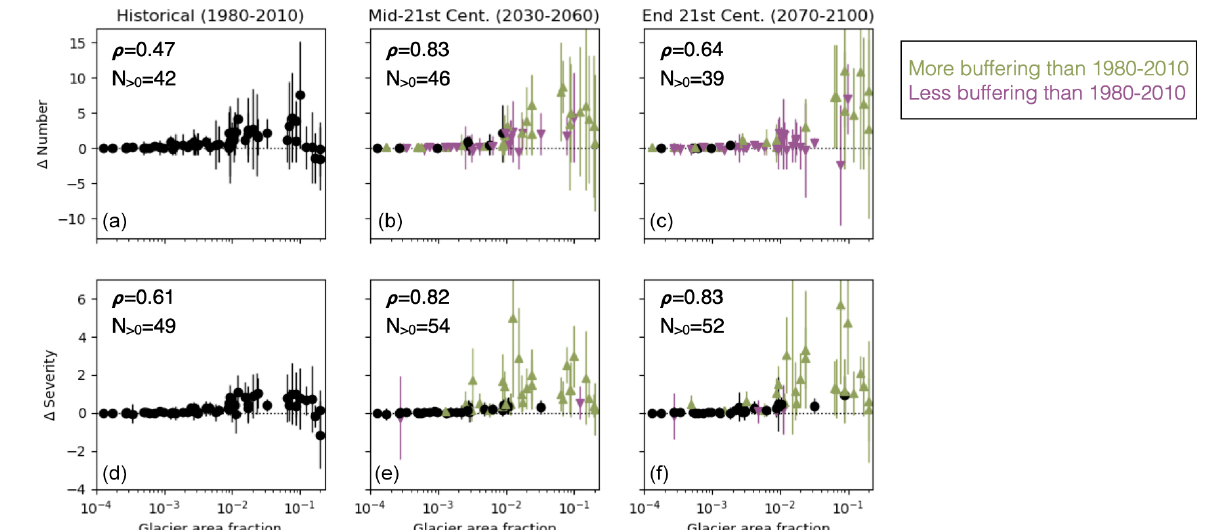
Figure A2. Glacial buffering of the number of droughts (a–c) and drought severity (d–f) , for the periods 1980–2010 (a, d) , 2030–2060 (b, e) , and 2070–2100 (c, f) , as in main text Fig. 3 but for RCP 8.5. Differences are given as the statistic on SPEI N − SPEI G , so a positive y -axis means positive buffering, i.e., there are more, and/or more severe, droughts in the without-glacial runoff series. X -axes are glacier area fraction A G /A presented on a logarithmic scale. Markers indicate the ensemble mean for each basin and whiskers indicate range among single-GCM results. In the second and third columns, color indicates change in ensemble mean buffering versus the historical period: green upward triangles for increased buffering, black dots for no change (tolerance of ± 0.1), and magenta downward triangles for decreased buffering. Annotations in the corner of each panel list Spearman’s rank correlation coefficient ρ between basin glaciated area and the statistic shown in that panel, as well as the number of basins for which multi-model mean buffering is positive, N > 0 .